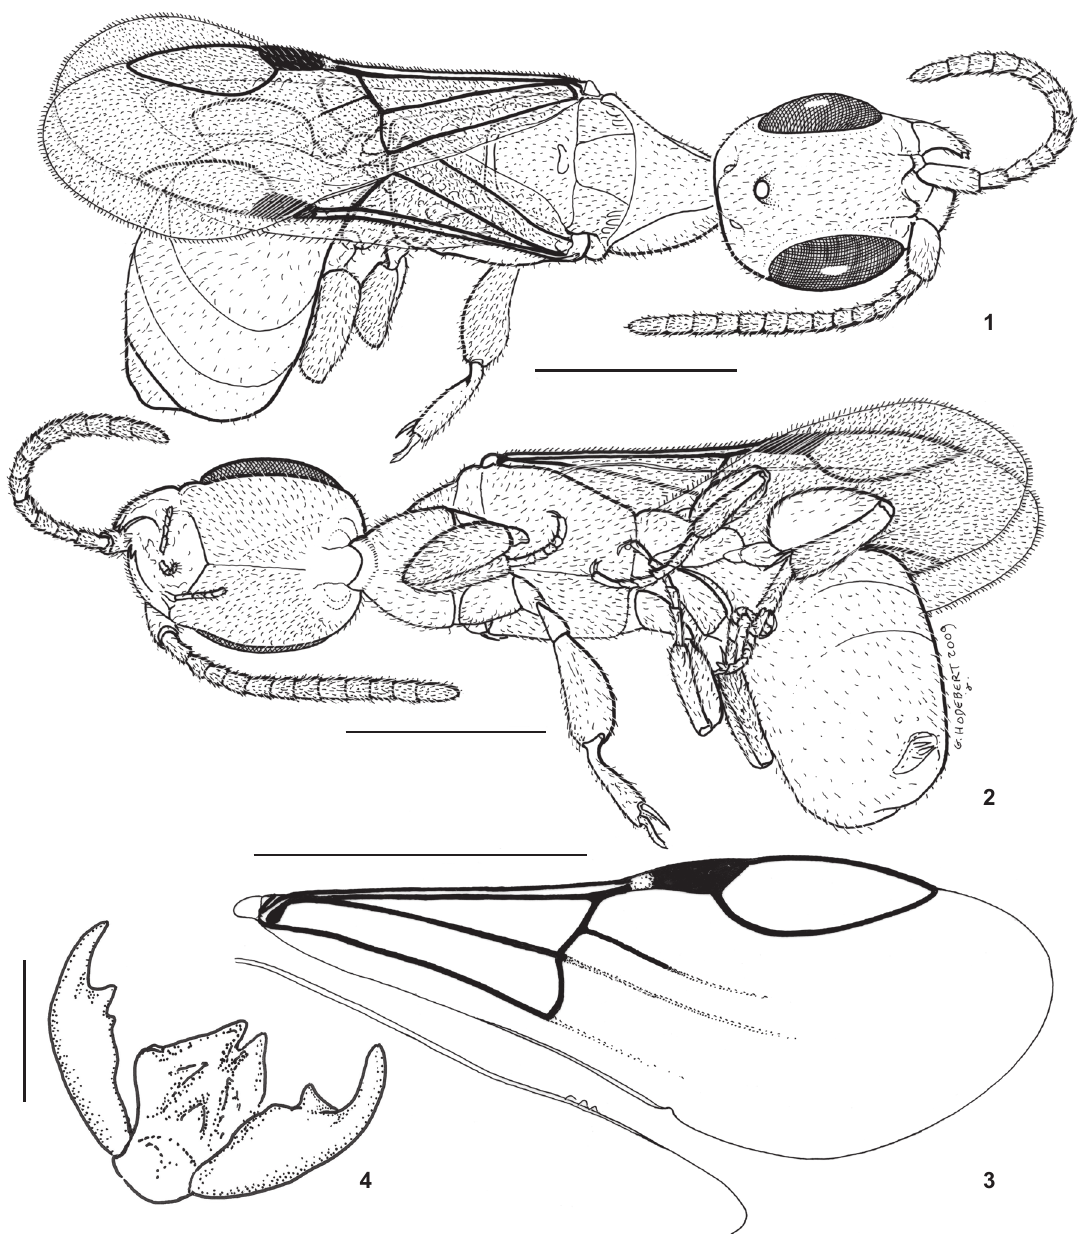
0.50 mm, vertical bar = 0.03